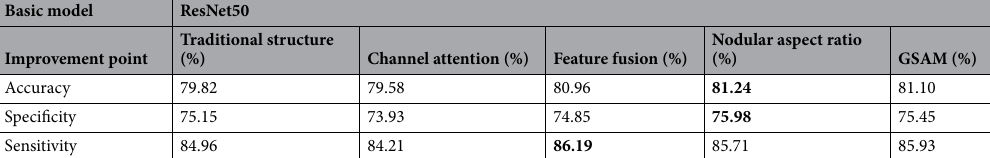
Table 4. Comparison of improvement points based on ResNet50. Significant values are in bold.